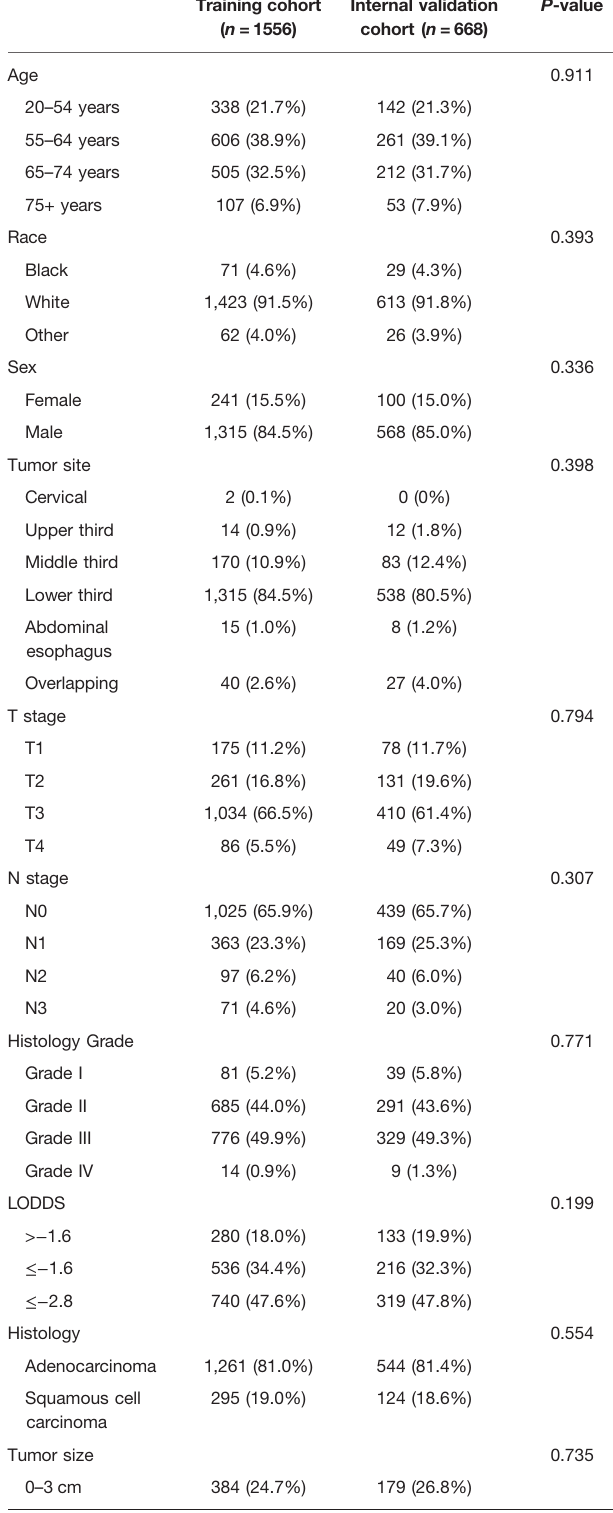
TABLE 1 | Demographics and clinicopathological characteristics of the training and internal validation